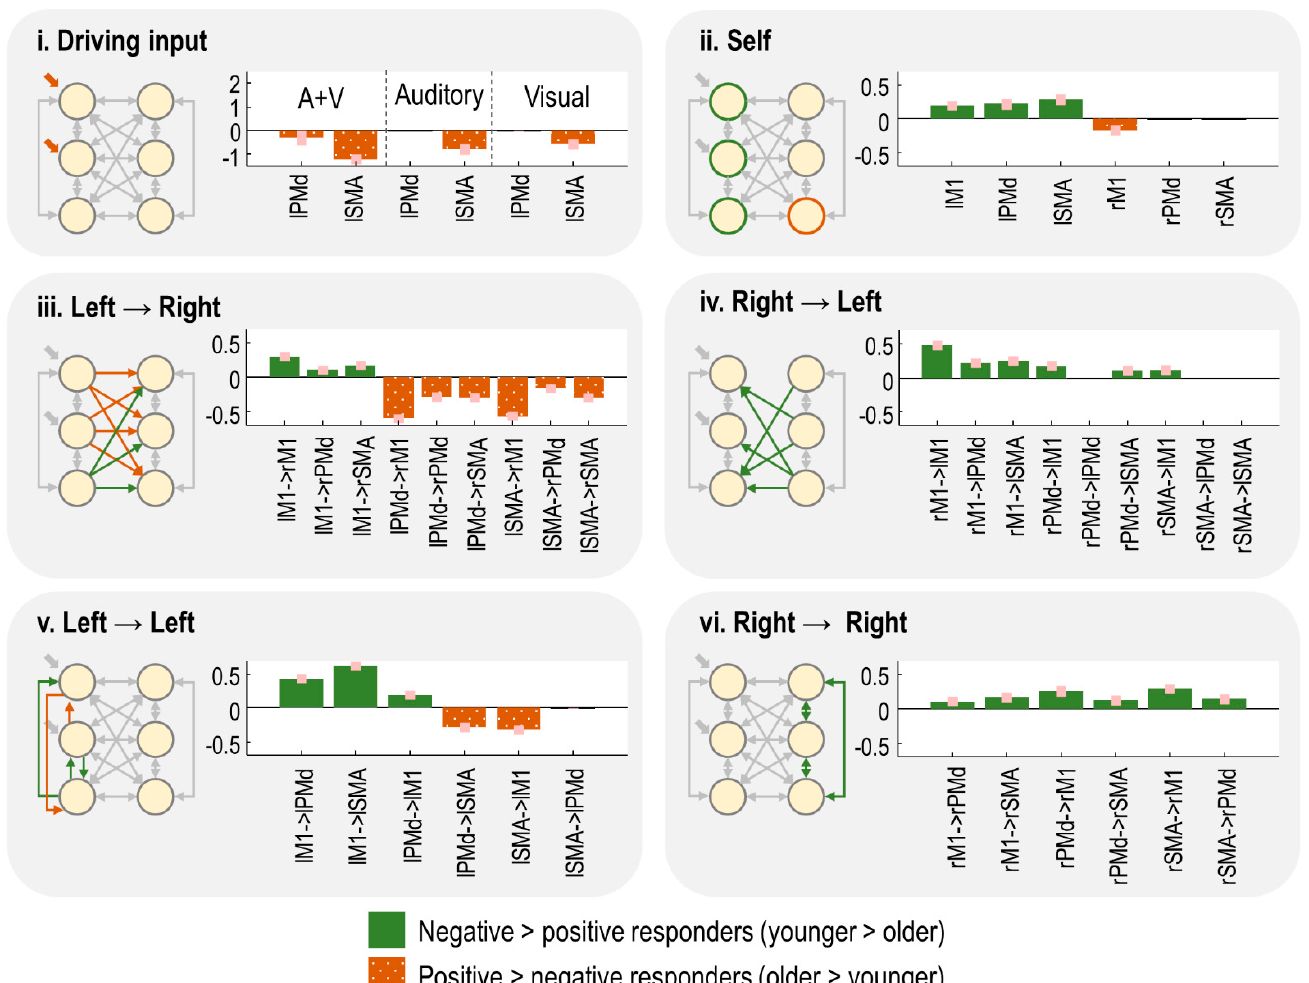
Figure 4. Group differences in neural parameters (negative minus positive responders). Within each panel, bars greater than zero indicate more positive parameters for the negative responder group (younger subjects); bars less than zero indicate more positive parameters for the positive responder group (older subjects). Each vertical axis is the estimated effect size, in units of Hz, for all panels except the self-connections ( panel ii .), which are unitless log-scaling parameters. Pink error bars are 90% Bayesian credible intervals. The network diagrams, inset, illustrate where in the model the connections can be found. Each circle is a brain region—refer to Figure 2 for region names.